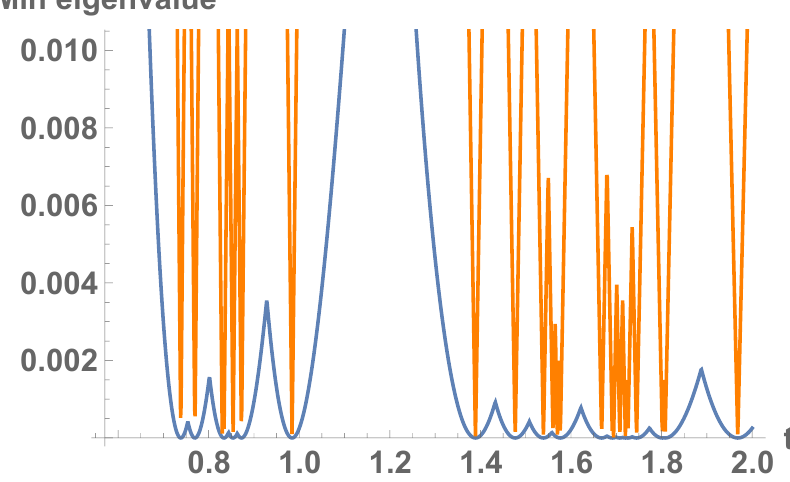
Figure 13 . The minimum eigenvalue of the super-operator (orange) and of the matrix M αβ (blue) for N = 6 fermions and the integrable interaction δH 1 with the same coupling strengths as chosen